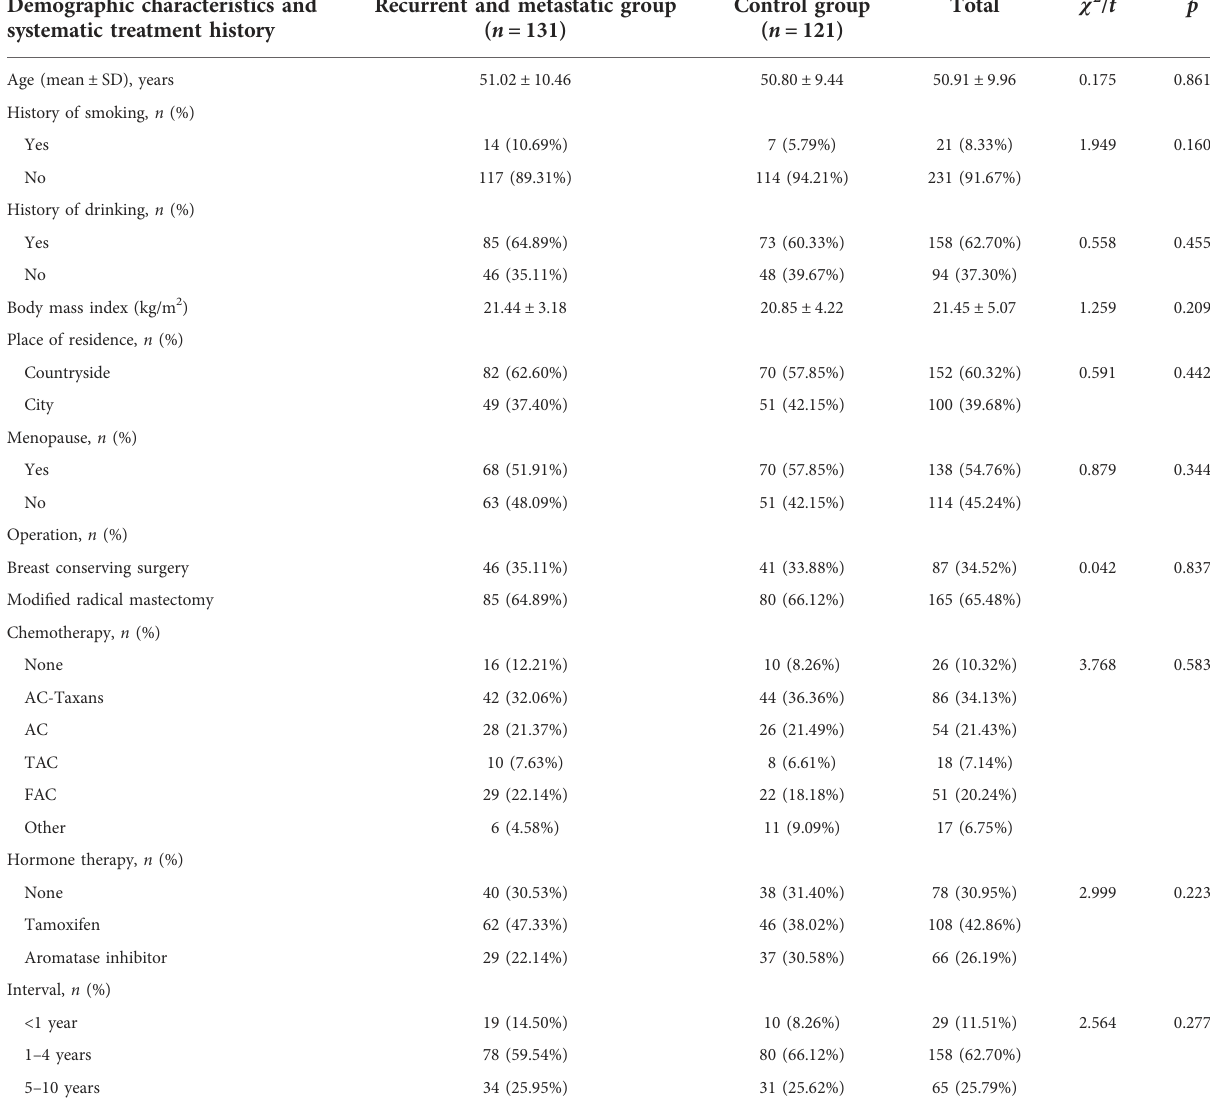
TABLE 1 Demographic characteristics and systematic treatment history of the two groups. Demographic characteristics and systematic treatment history